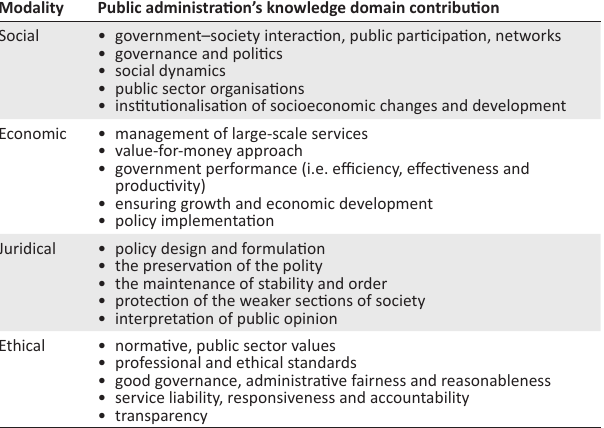
TABLE 1: Synopsis of public administration modal contribution to